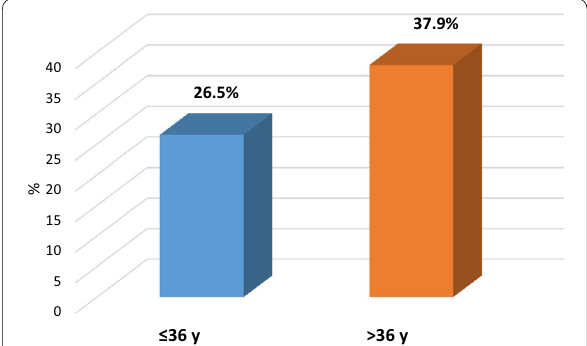
Fig. 2 Gender of the patients as predictor of moderate and severe insomnia